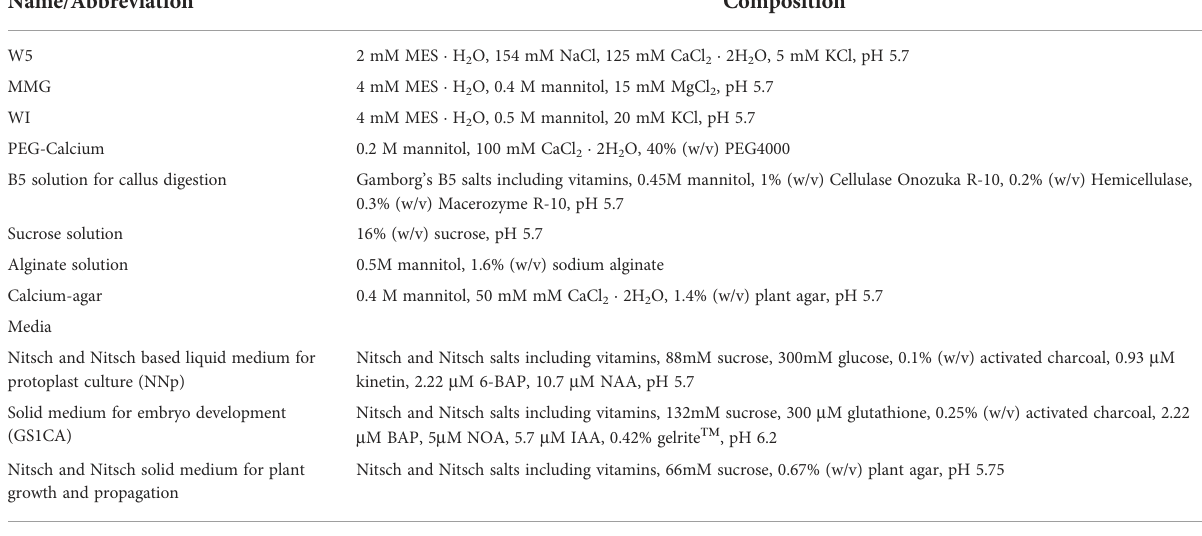
TABLE 1 List of solutions/buffers required to perform protoplast isolation, transfection, and regeneration with the respective composition.